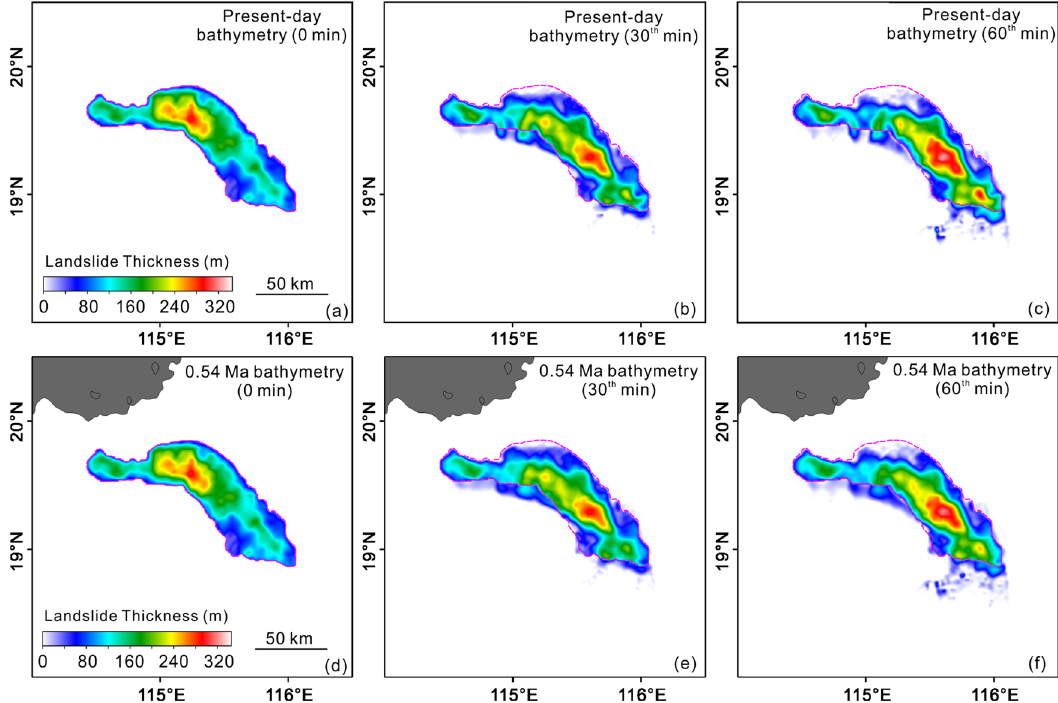
Fig. 5 Modeled movement of failed sediment. a – c Modeled movement of failed sediment and its distribution at 0, 30, and 60 min considering the present- day bathymetry and shoreline position. d – f Modeled movement of failed sediment and distribution at 0, 30, and 60 min considering the 0.54 Ma bathymetry and shoreline position. Bathymetry has a reduced in fl uence on the movement of failed sediment and its